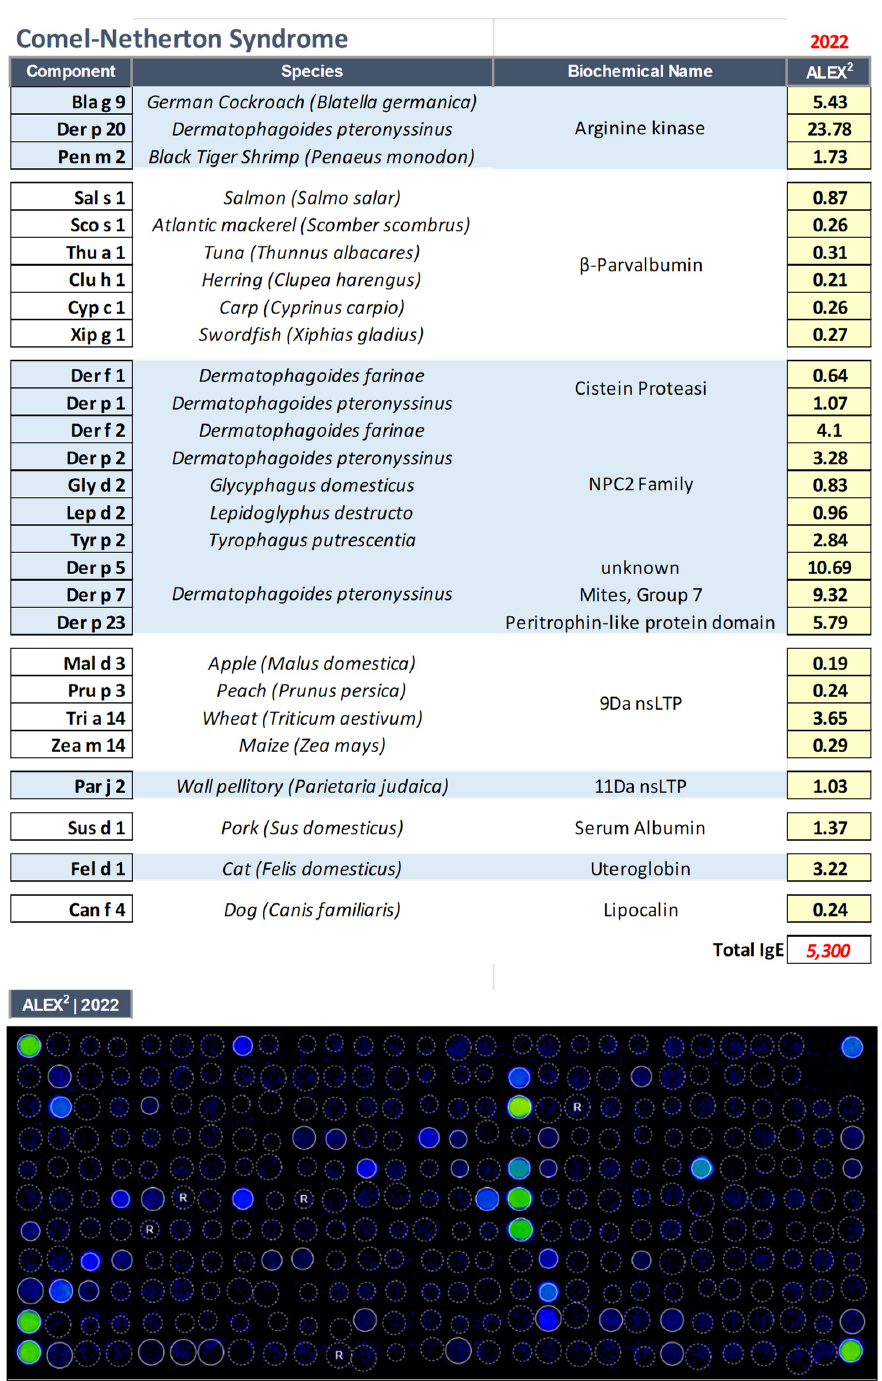
Figure 2. IgE sensitization profile as evaluated through multiplexed proteomic evaluations with Allergy Explorer–ALEX2®2 macroarray in the patient affected by Comel–Netherton Syndrome (NS, OMIM: 256500) .